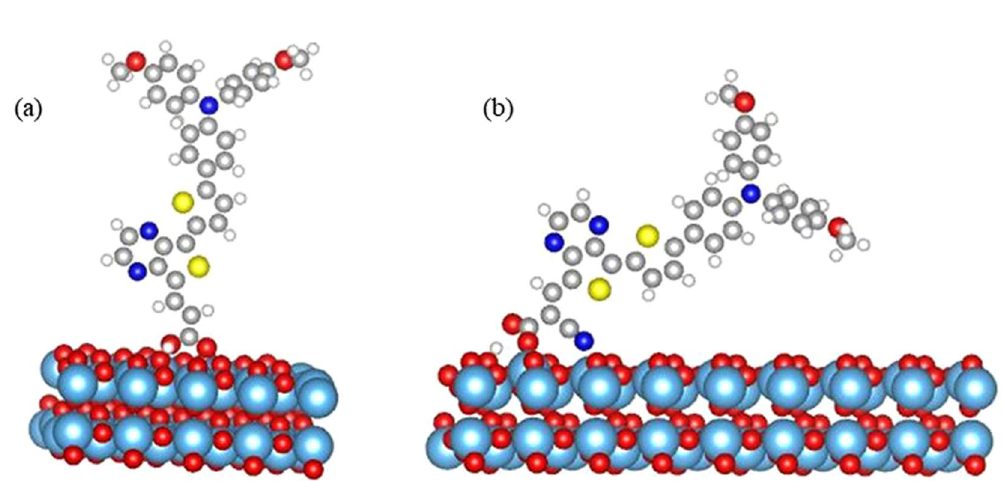
Figure 11. The optimized structures of ( a ) D π -TP-COOH dye in A3 configuration and ( b ) D π TP- CN COOH dye in B5 configuration on TiO 2 anatase (101)